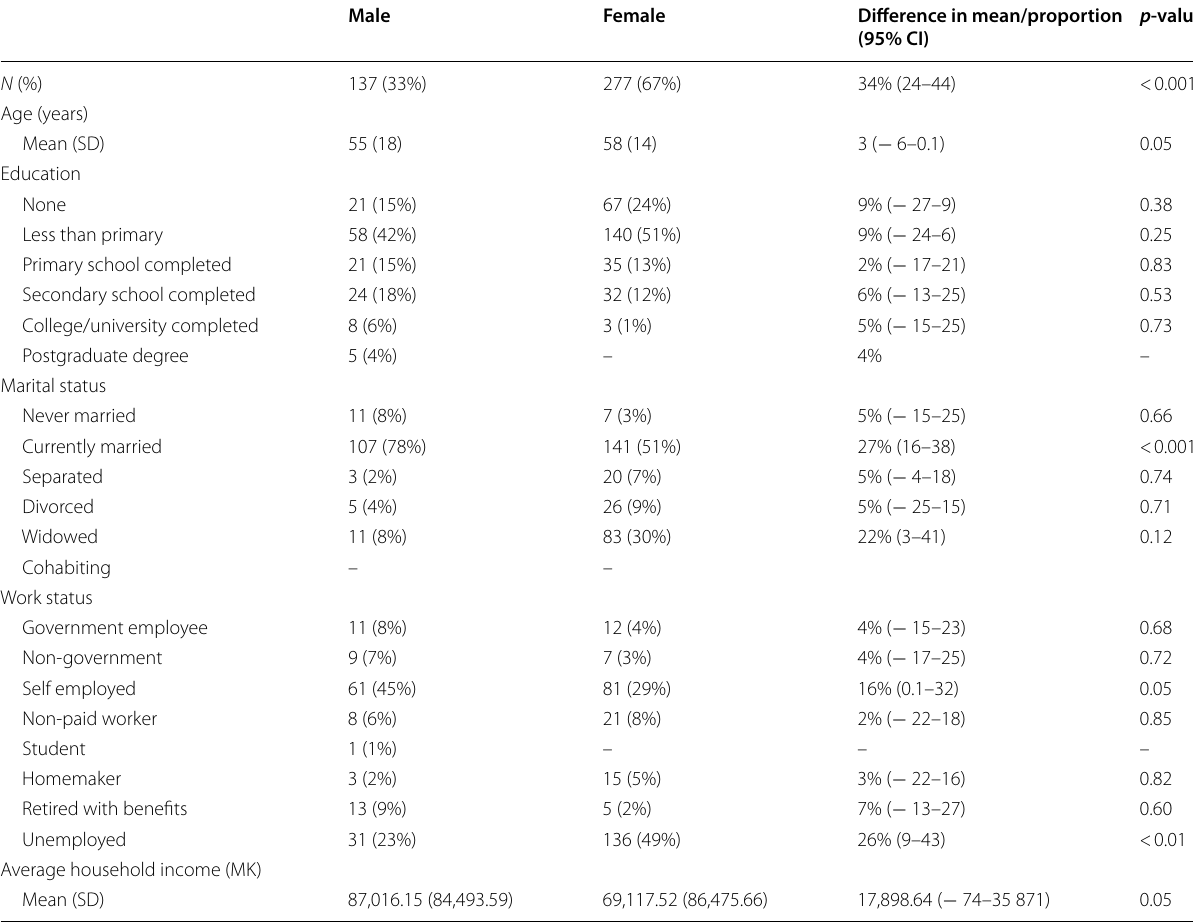
Table 1 Baseline sociodemographic characteristics of male and female participants